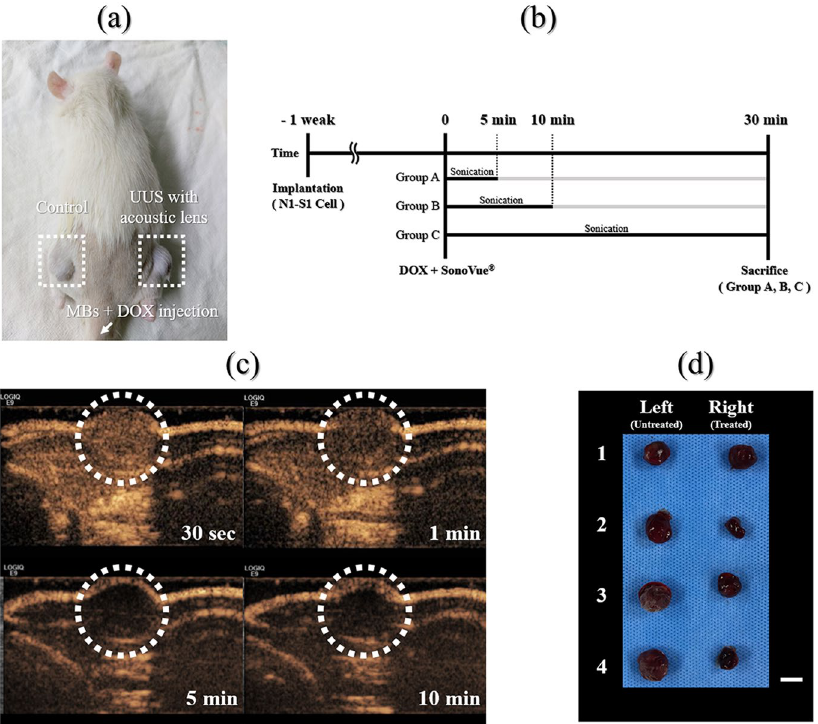
Figure 4. Animal experiment. ( a ) Photograph of the subcutaneous hepatoma rat model. ( b ) An illustration of the in vivo experimental setup. Doxorubicin (DOX) was firstly injected via the tail vein, and then the ultrasound treatment system was applied during each treatment time at one side. Microbubbles (MBs) were immediately injected after DOX injection. Ultrasound irradiation occurred immediately after injecting the MBs and DOX. The rats were sacrificed 30 min after the start of sonication, and the tumors were extracted to measure the DOX concentration. ( c ) Photograph of the contrast-enhanced ultrasound images after injection of the MBs. The dotted circle represents the concentration of MBs in the tumor over time. Contrast-enhanced ultrasound images were only obtained to determine the ultrasound-treated time. ( d ) Photograph of the extracted tumors from the subcutaneous hepatoma of rat models (scale bar = 1